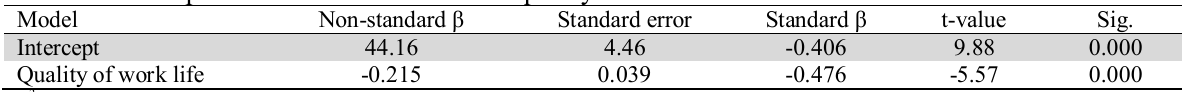
The relationship between mental health and quality of work life